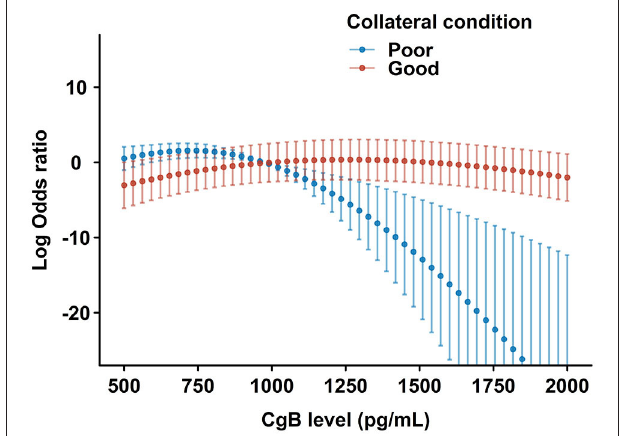
FIGURE 4 | Restricted cubic spline plots for the likelihood of LV functional recovery by CgB levels after multivariate adjustment. The central dots and error bars represent the adjusted odds ratios and 95% confidence intervals in patients with poor (blue) or good (red) collateral conditions after CTO- percutaneous coronary intervention